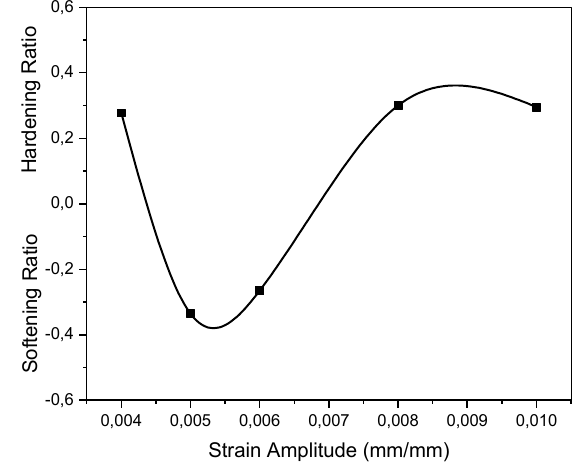
Figure 9. The cyclic softening or hardening ratio of magne– sium in the LCF test with a constant strain rate of 0.00627